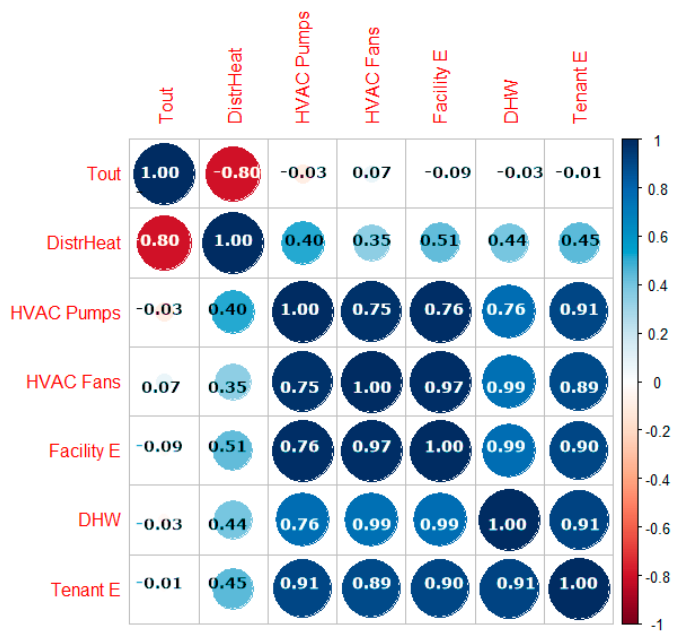
Figure 2. Correlation matrix for the set of predictors, monthly averages from 2014 to 2018 .